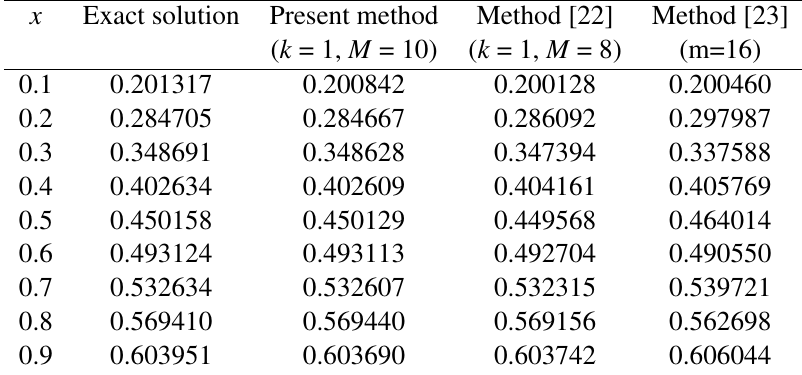
Table 2 Numerical results of example 2.